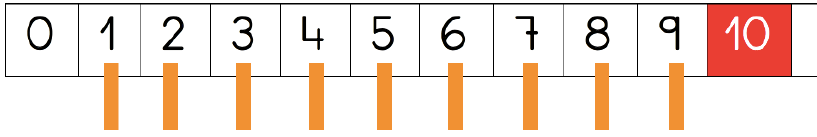
Figure 10. The first nine natural number highlighted.